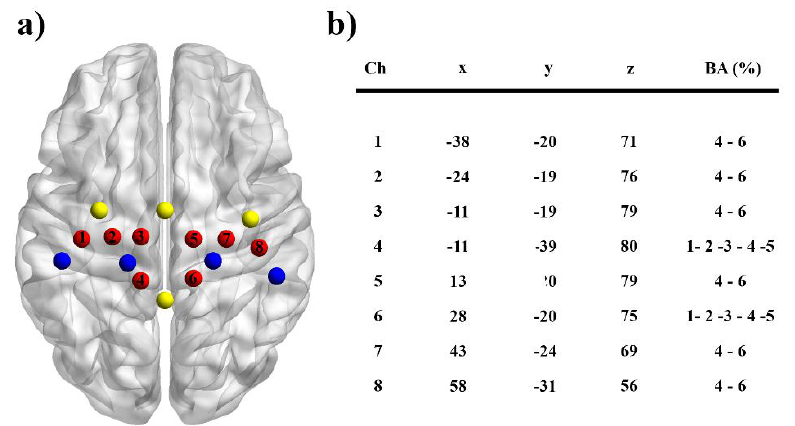
Figure 3. ( a ) Spatial organization of the fNIRS probes for the contralateral and ipsilateral primary motor (M1) cortices for one representative participant. Each M1 area was explored by 4 channels (in red) midway between the detectors (in blue) and the sources (in yellow) (BrainNet viewer toolbox). ( b ) MNI coordinates for each channel and corresponding Brodmann areas (BA).